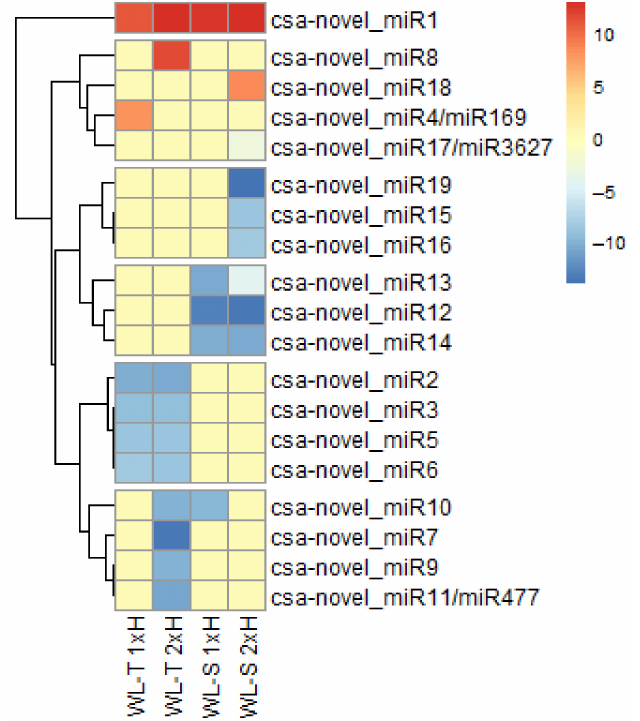
Figure 10. miRNAs differentially expressed in non-primed (1xH) and primed (2xH) cucumber WL-T and WL-S accessions under long-term waterlogging. The heatmap represents log 2 FC values in comparison to control conditions with FDR <